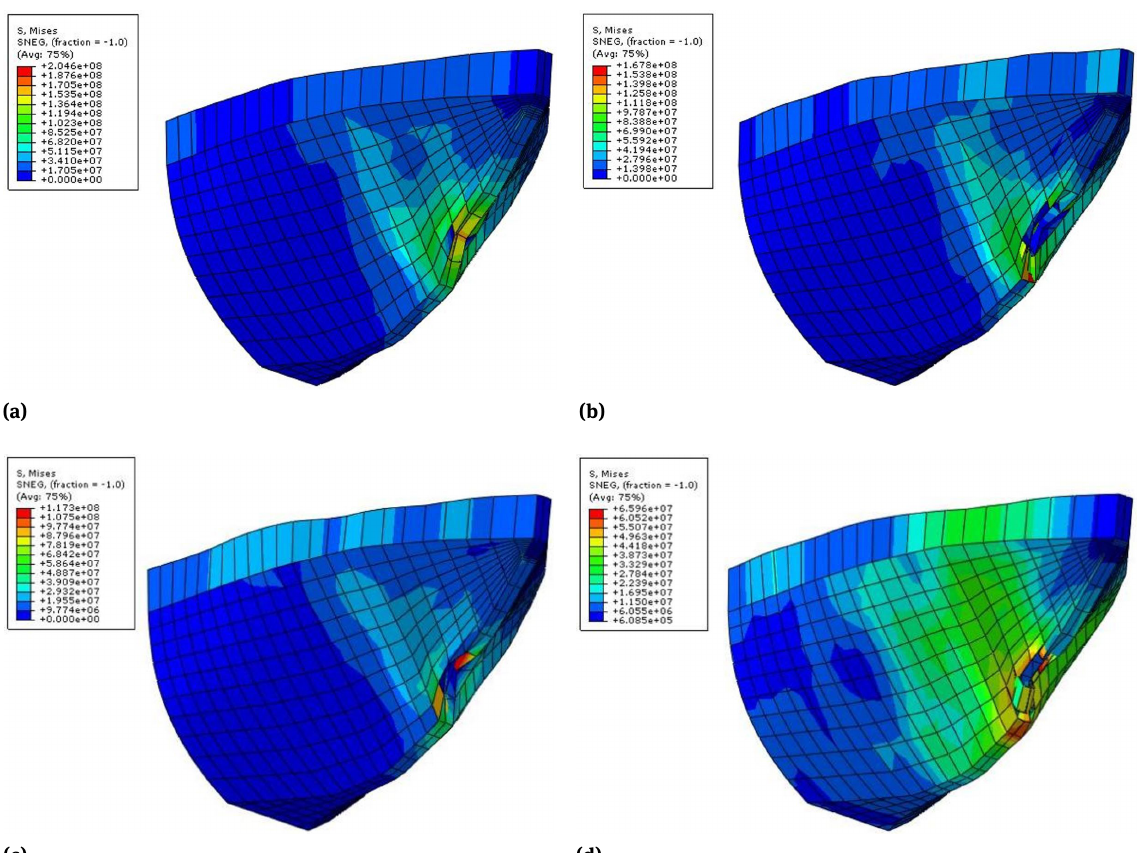
Figure 33: Deformation of the hull construction due to an impact at a speed of 4 knots: (a) Laminate type 1, (b) Laminate type 2, (c) Laminate type 3, (d) Laminate type